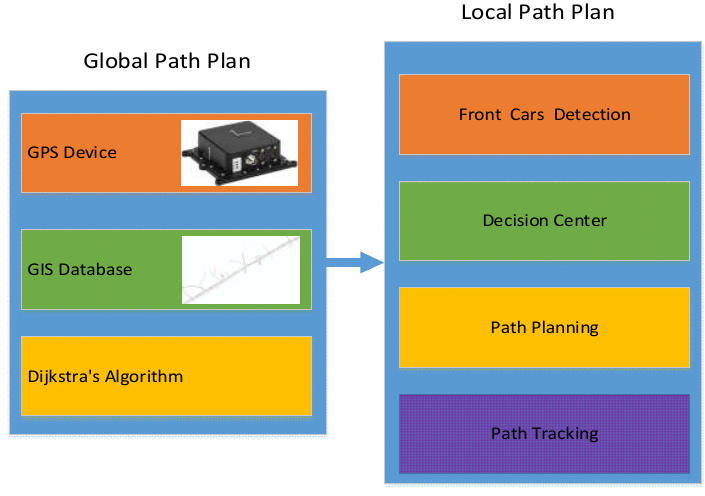
Figure 1. Path planning framework of driverless car.